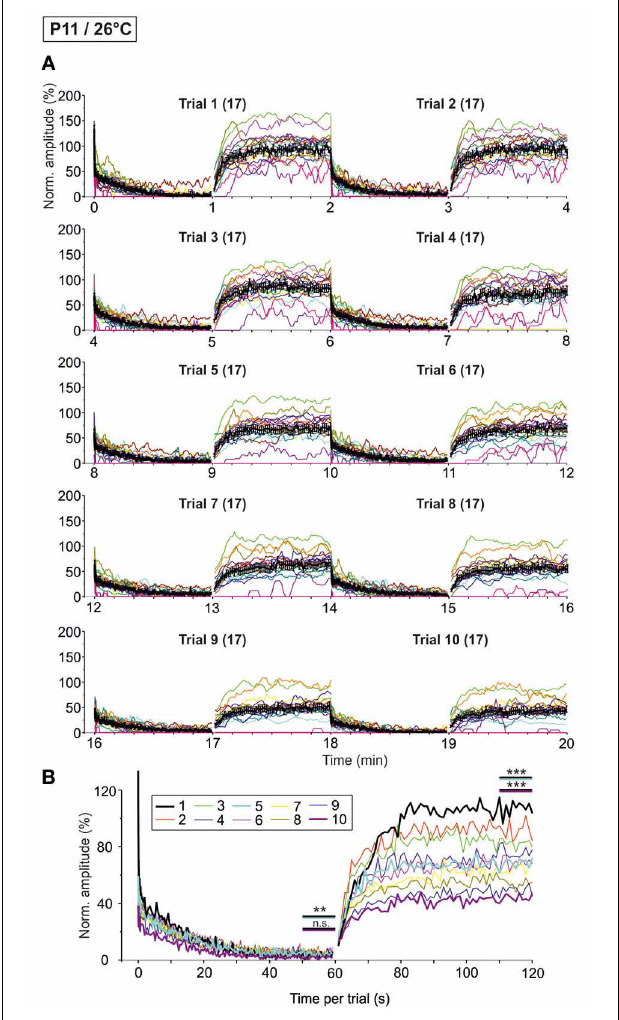
FIGURE 11 | Time course of depression and recovery of IPSC peak amplitudes at P11/26 ◦ C upon very prolonged stimulation. Same procedure as in Figure 10 , except that recordings were obtained at 26 ◦ C. (A) Time course of the IPSC peak amplitudes (one color per neuron, n = 17). Mean values ± s.e.m. are shown in black (simple moving average of five data points). (B) Superposition of the ten averaged time courses, illustrating the differences between trials, particularly during the recovery phases (traces for trials1,5,and10arehighlightedbyathickblack,turquoise,andmagentaline, respectively). Statistical comparison was done between trials 1 and 5 and trails 1 and 10. ∗∗ p < 0 . 01; ∗∗∗ p < 0 .